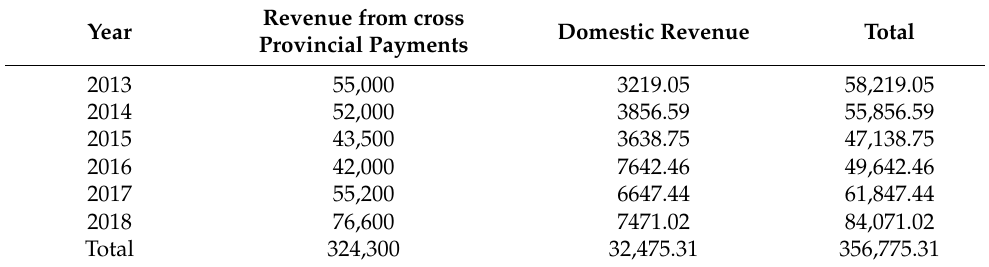
Table 3. Total PFES collected from users in Dak Lak province (VND ×